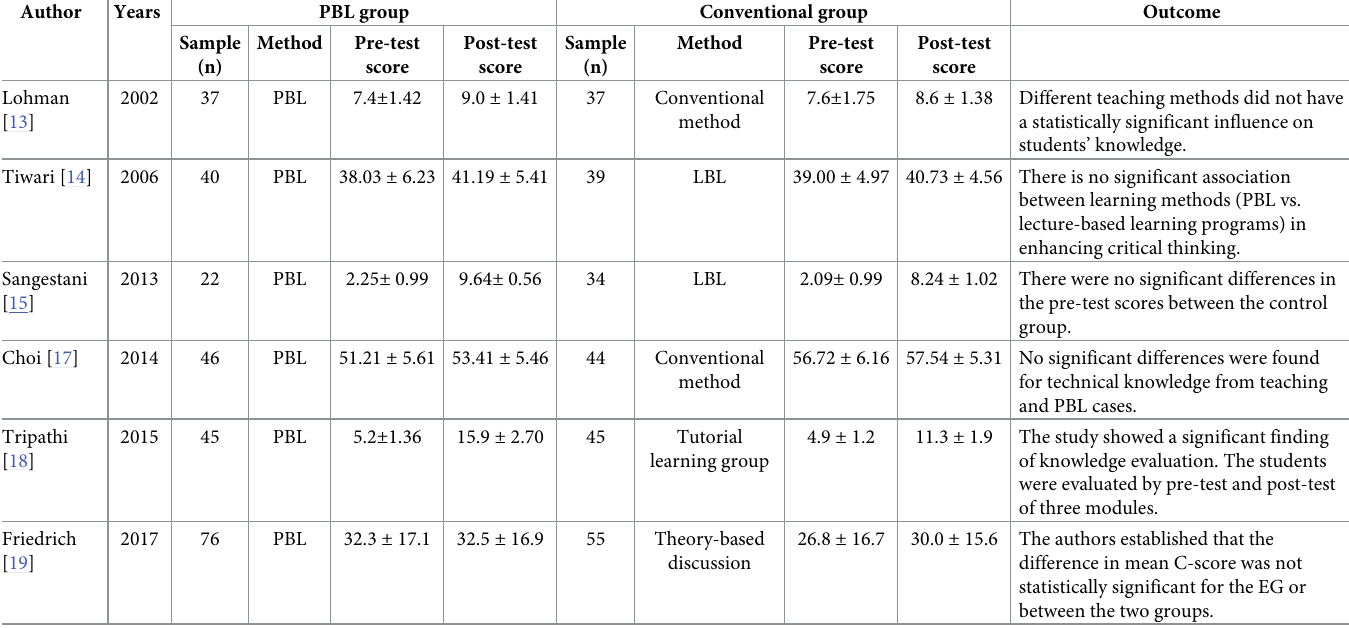
Table 2. The outcome of critical thinking/knowledge. This table provides pre/post-test results in each group and the authors’ interpretation of their funding.